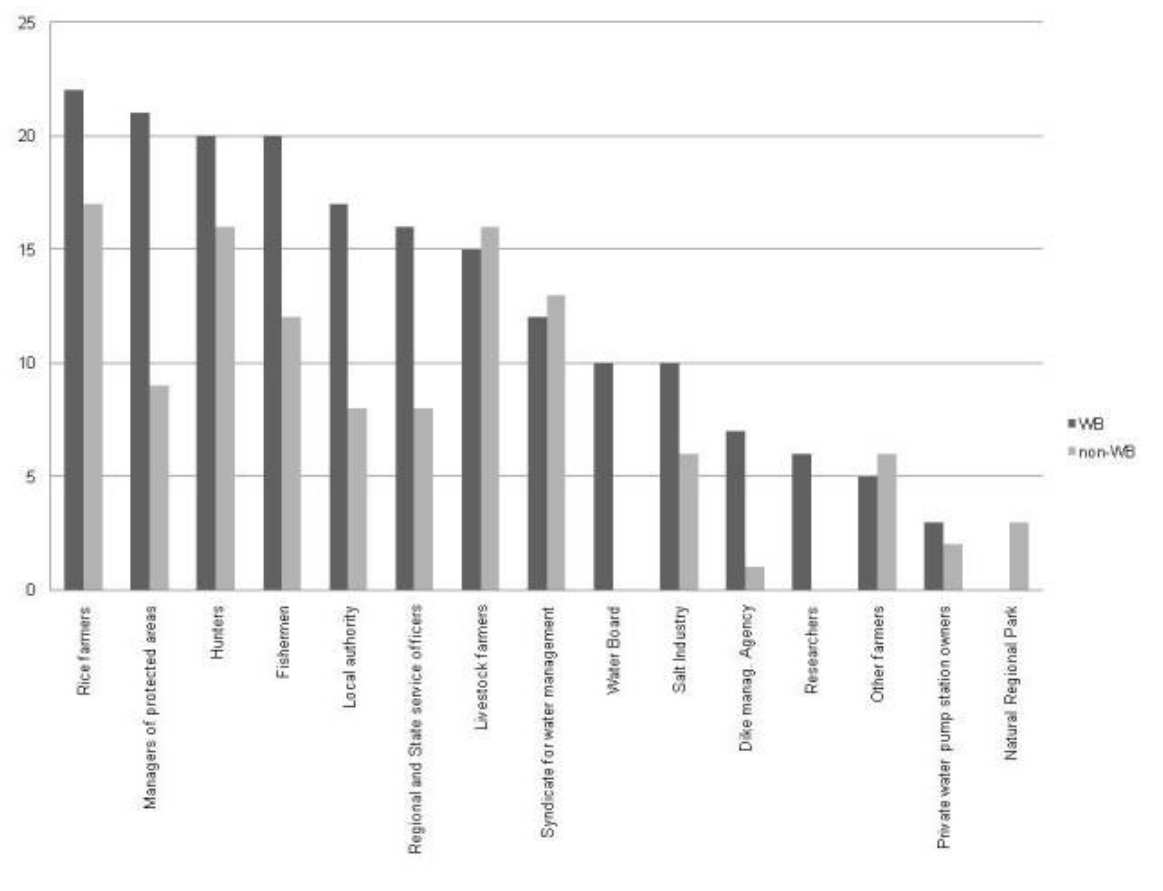
Fig. 2 . Frequency with which members (WB) and nonmembers (non–WB) of the Water Board listed each of the main